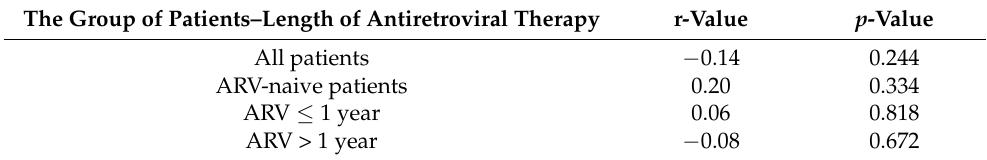
Table 6. The correlation between patients’ age and VCAM-1 level.